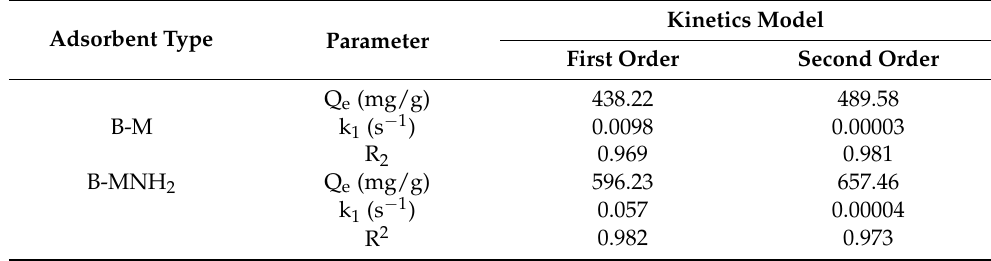
Table 2. Kinetic parameters of Pb(II) ion adsorption using B-M and B-MNH 2 as an